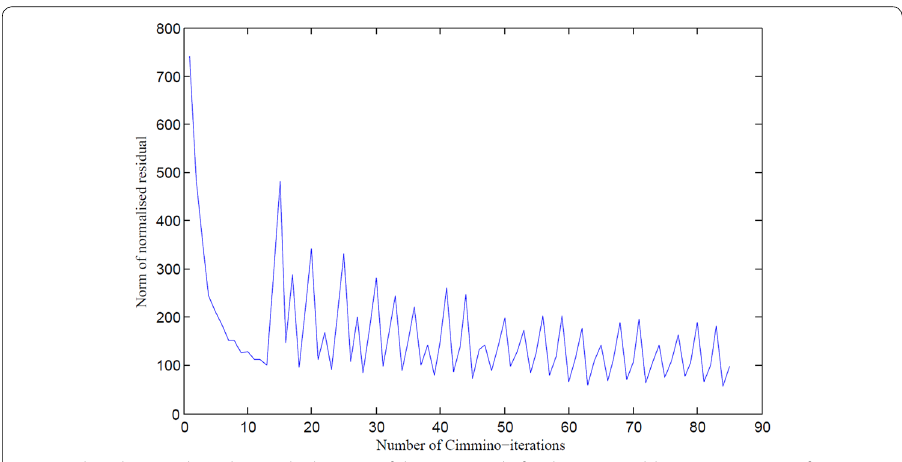
Fig. 7 This plot visualises the residual norms of the ACIM code for the Eora problem. A maximum of 100 Cimmino iterations were allowed between two Hildreth iterations. Both the Cimmino- and the Hildreth iterations were terminated when a residual norm of less than 100 was achieved